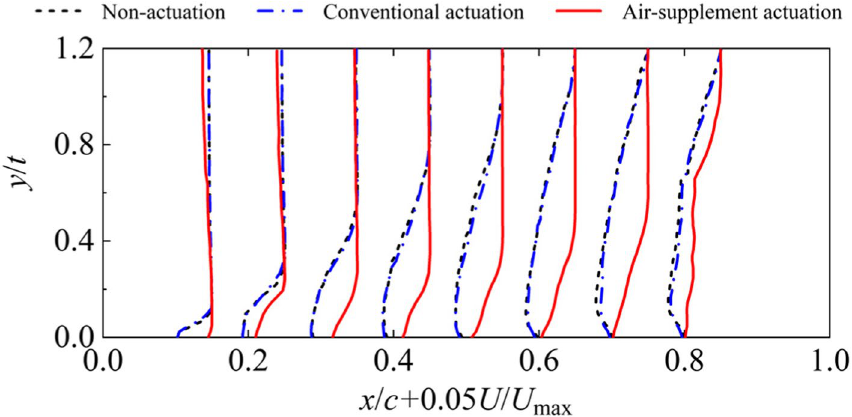
Fig. 9 Velocity profile of the suction surface under different actuation states at α